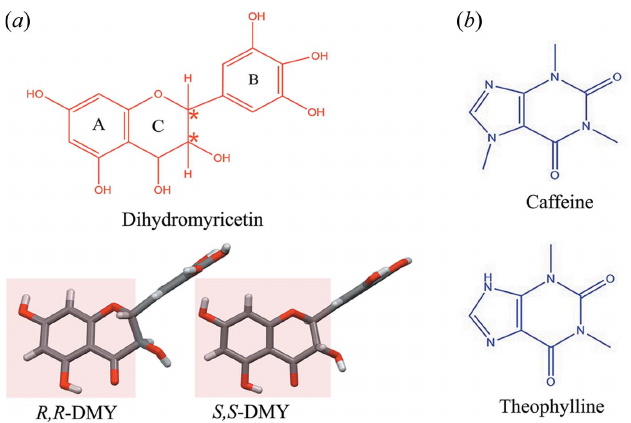
Figure 1 Molecular structure of ( a ) DMYand the two selected coformers ( b ) CAF and THE. The two chiral carbons are highlighted in red stars with the two predominant enantiomers of DMY in solution (coplanar A and C six- membered rings are highlighted in light